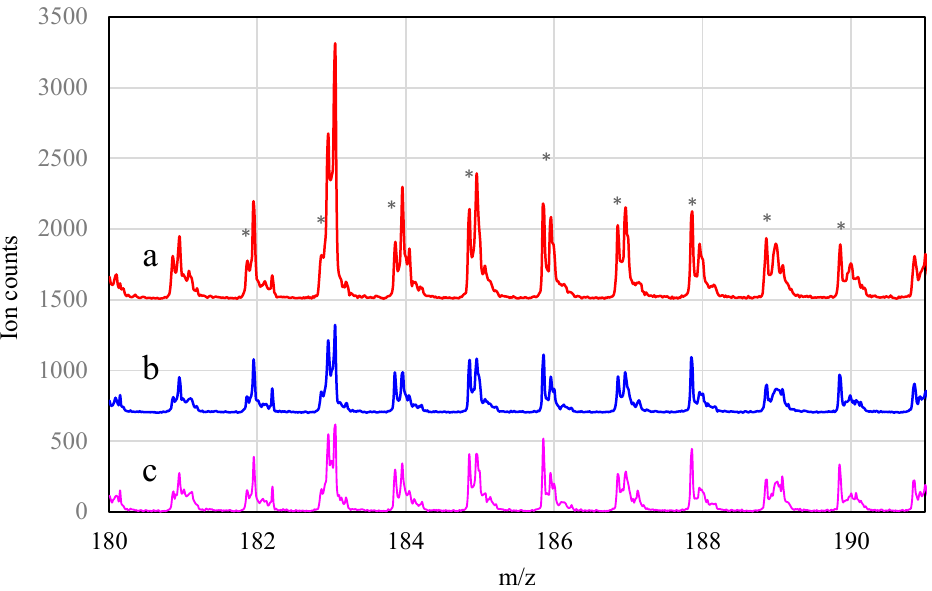
Figure 9. TOF–SIMS spectrum of the 5%Pd/TiO 2 catalyst after impregnation (a), reduction (b), and reaction (c); * peaks assigned to PdTiO 2+ ions in ToF-SIMS spectra.